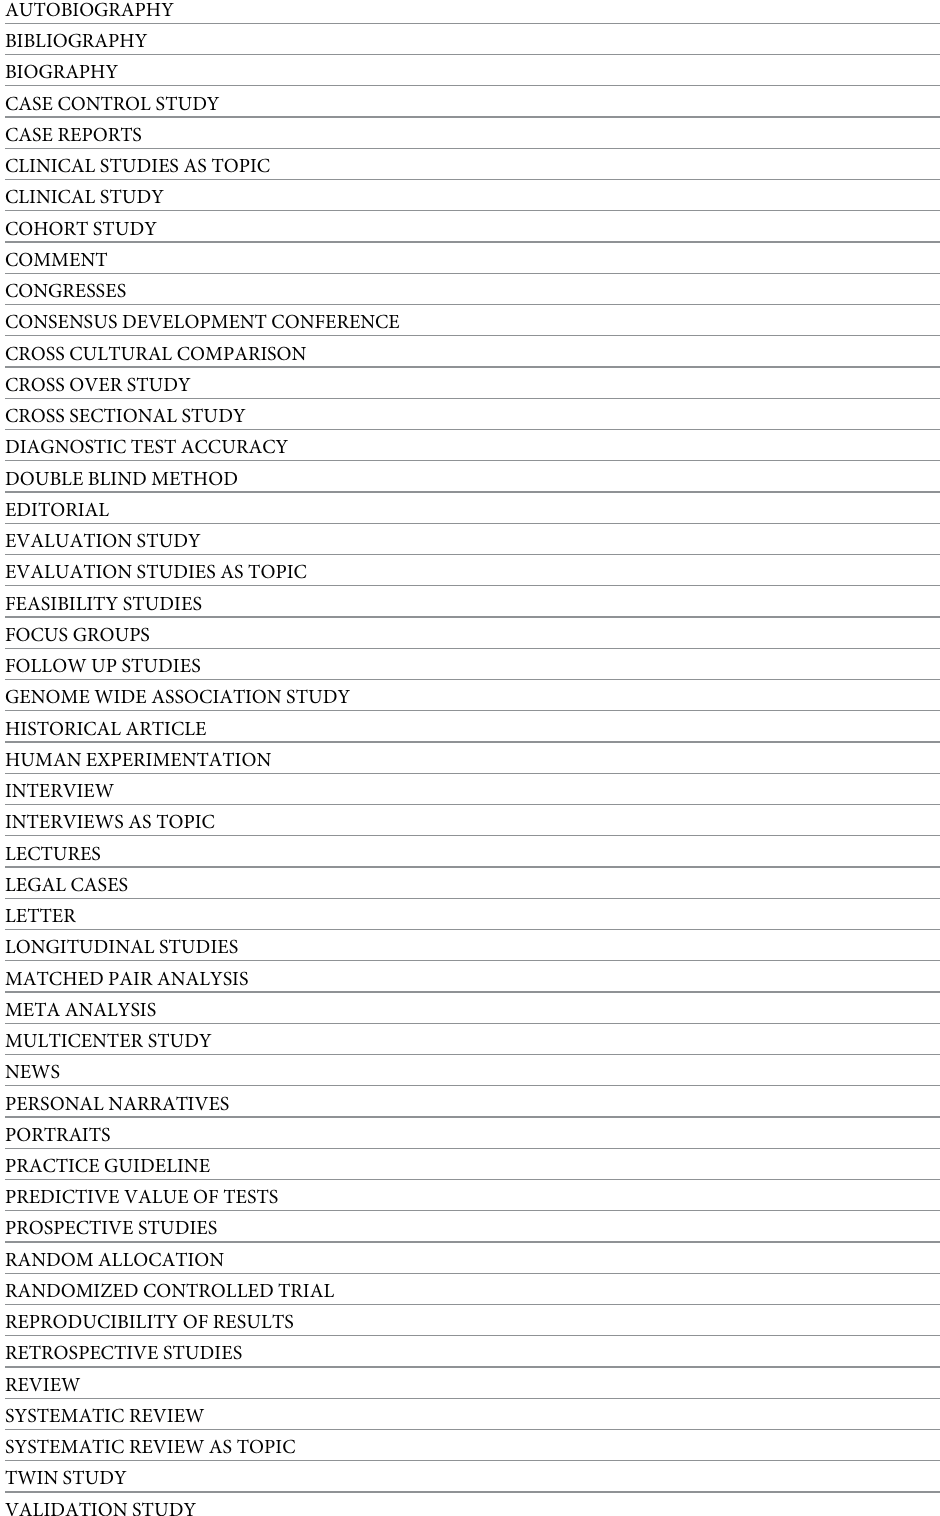
Table 1. Publication types and study designs for augmented display and